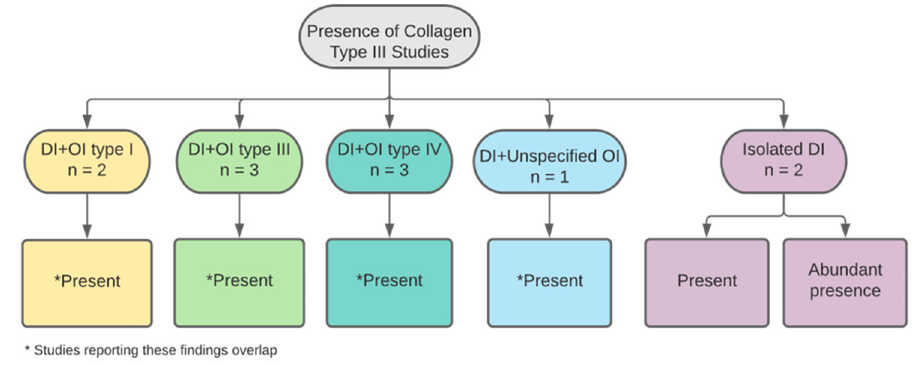
Figure 12 . Categorisation of studies reporting on collagen type III by DI and OI types